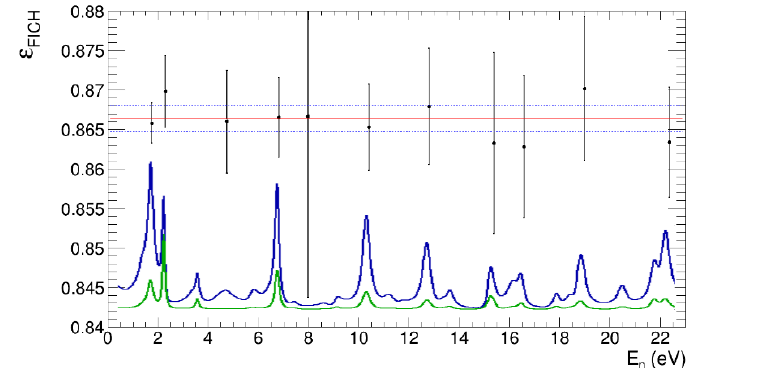
Fig. 9. Efficiency of the fission chamber as a function of neutron energy for events with fission amplitudes bigger than 3000 channels of the ADC and 10 MeV < E Sum < 20 MeV and m cr > 6. The red line is a fitted constant function and the blue dashed line indicates the error band of the fit. The solid blue and green line at the bottom illustrate the shape of the ENDF/B-VIII.0 fission and capture cross section